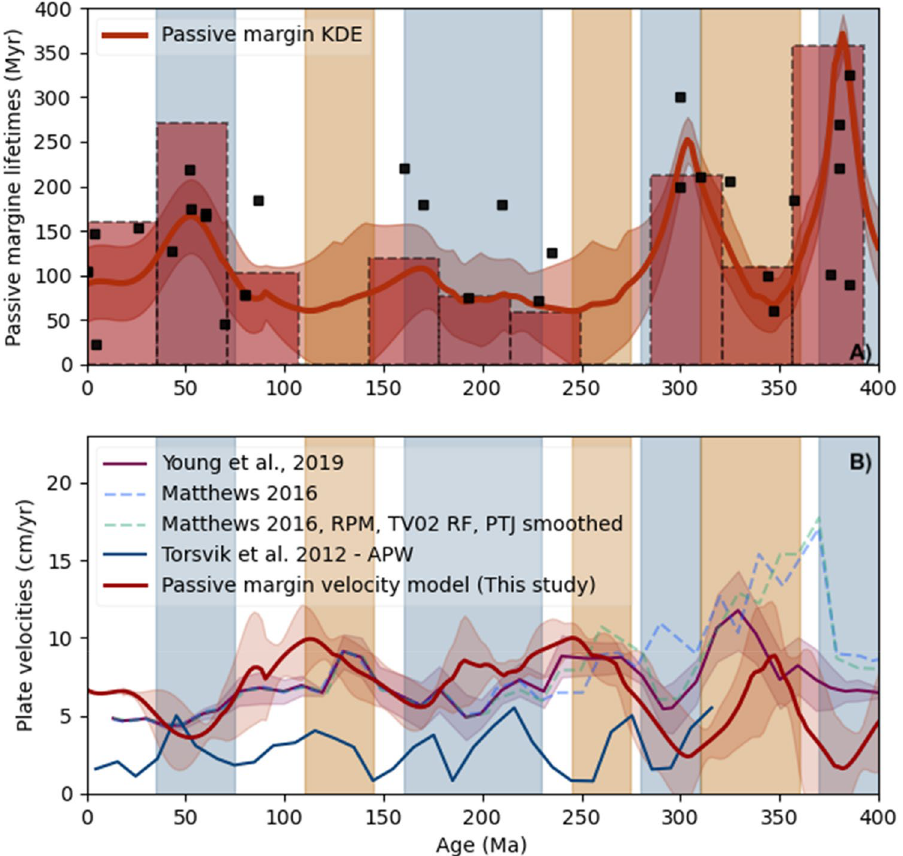
Figure 2. Passive margins and plate velocities in the Phanerozoic. ( A ) Passive margin evolution since 400 Ma (from Bradley 7 ) (excluding passive margins that are developing at the present-day). Black squares indicate end of margin lifetime. Red bars show a weighted histogram through the data, with weights calculated from margin lifespans. Red line indicates a weighted kernel density estimate through the dataset, with standard deviations calculated from local data density shaded. Orange and blue divisions indicate periods of short- or long-lived passive margins, respectively. ( B ) Phanerozoic global plate velocity models of Young et al. 48 (purple), and Matthews et al. 1 (green and blue dashed line). The orange and blue divisions here correlate with periods of high and low plate velocity, respectively, and anticorrelate with the passive margin ages observed in a). We have used the KDE estimate shown in a to invert for velocity, with the result shown as a thick red line in b. We are able replicate the timing and magnitude of velocity excursions of Young et al. 48 within the uncertainties of each dataset. Competing velocity models diverge beyond 300 Ma, increasing the uncertainty of the plate estimates. Also, for times less than 50 Ma, passive margin lifetimes are less well constrained, because many are still forming. We have also plotted the APW model of Torsvik et al. 21 (blue), for comparison with global velocity